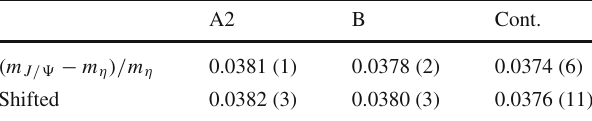
Table 5 Quark mass shifts to correct the mistuning of φ 4 and φ 5 and final lattice spacings